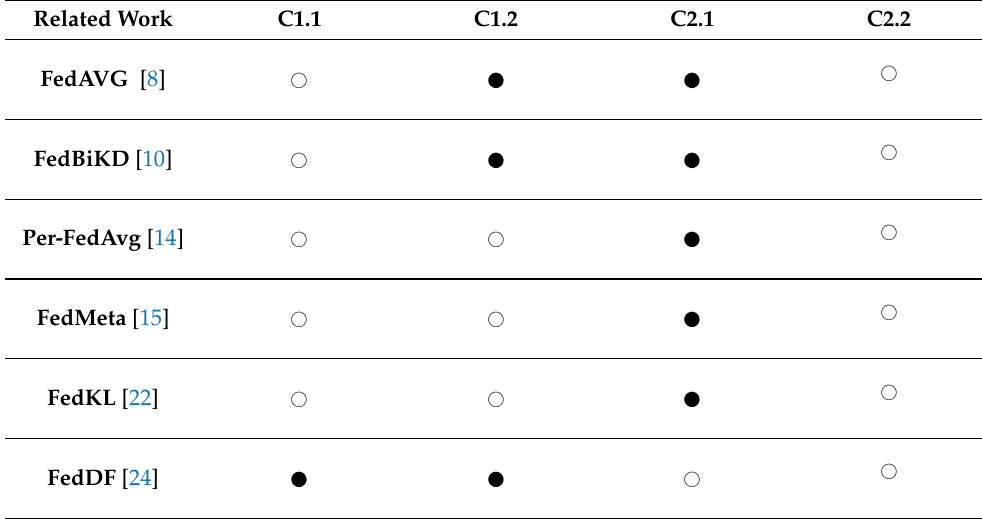
NOT SUPPORTED and (cid:35)